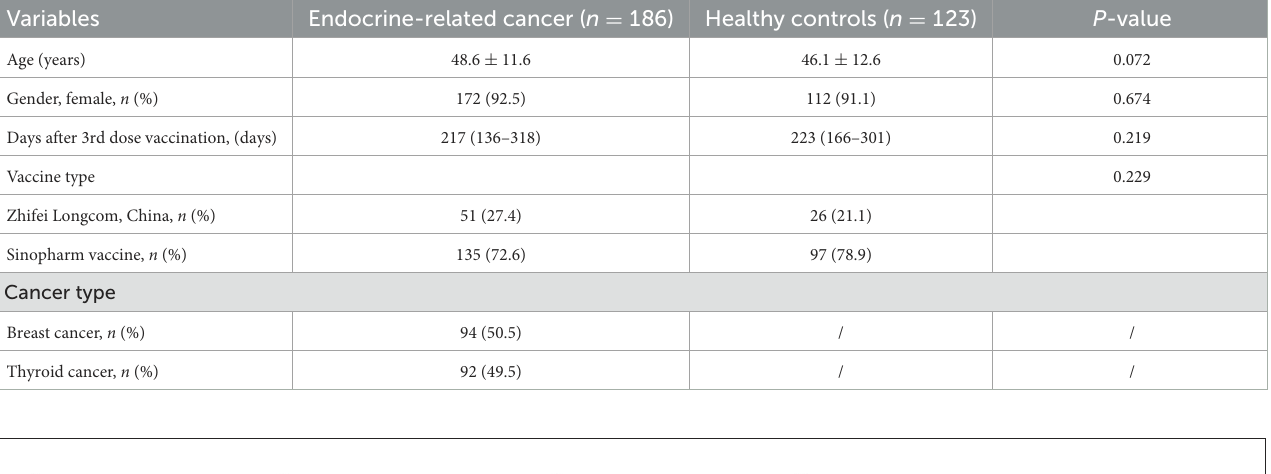
TABLE 1 Demographic characteristics of participants.